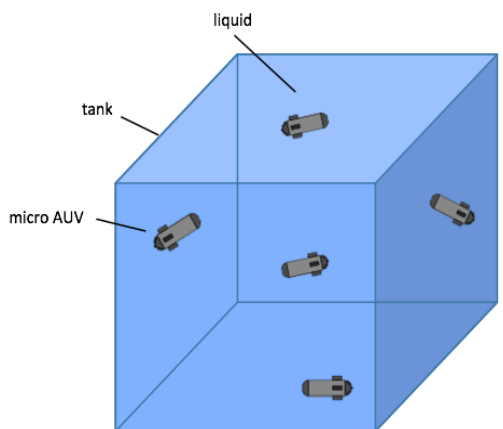
Figure 2. Illustration of an application scenario for a fleet of µ AUVs. A confined tank contains a liquid with an underlying concentration field of interest. The µ AUVs perform adaptive measurements to collect information and to infer the state of the concentration